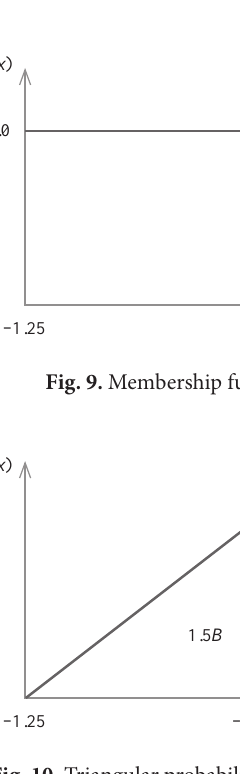
Fig. 10. Triangular probability distribution for the